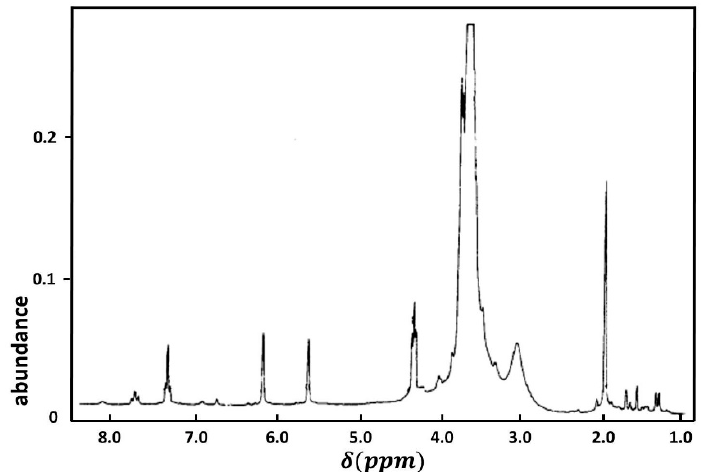
Figure 1. The FTIR spectrum of PEG-DM Macro Crosslinker.